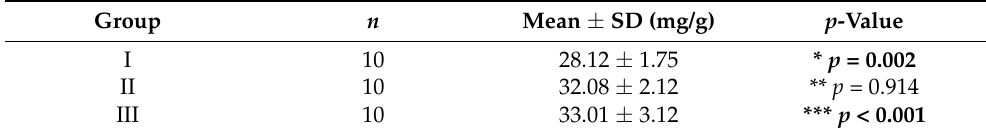
Table 2. A quantitative analysis of total protein in teeth enamel in groups with different stages of fluorosis. Group n Mean ± SD